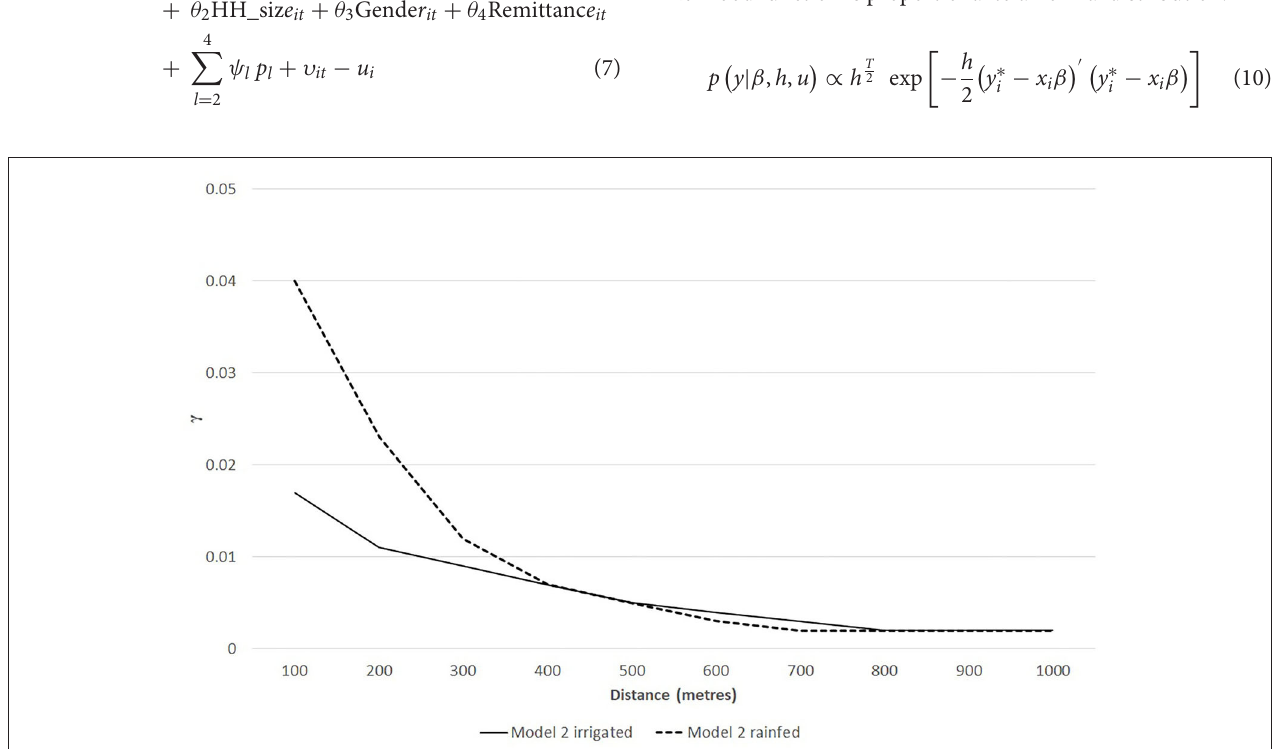
Frontiers in Sustainable Food Systems |